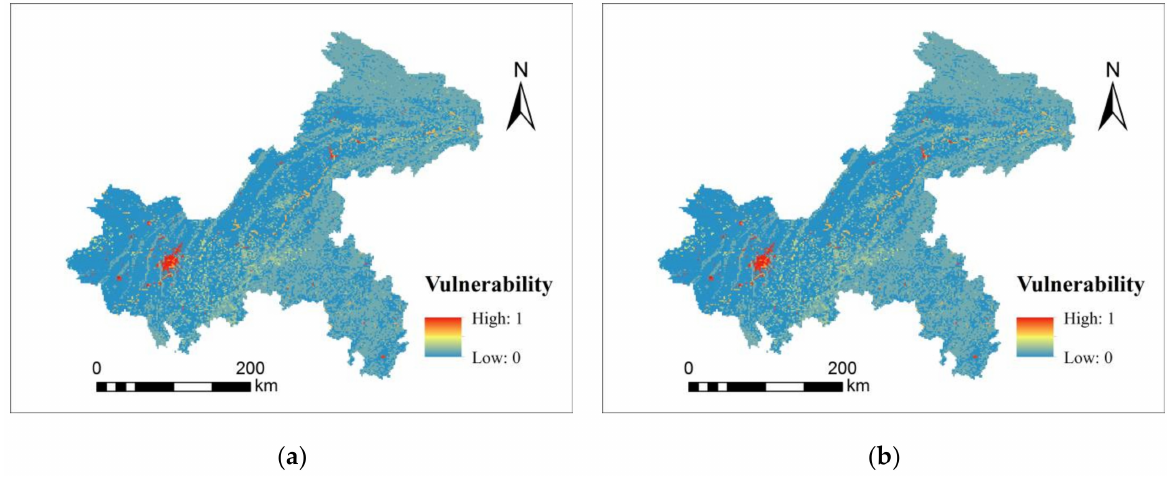
Figure 9. Spatial distribution map of flood vulnerability: ( a ) AHP, ( b ) TFN-AHP.